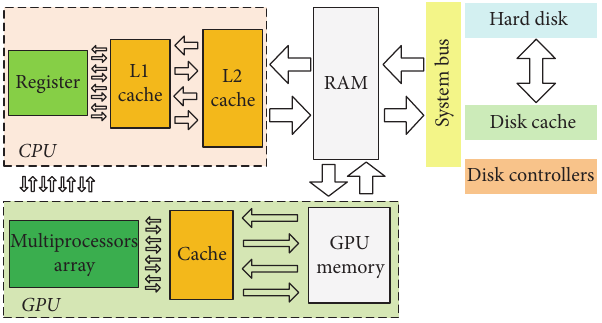
Figure 7: Multilevel storage architecture of a CPU/GPU platform.